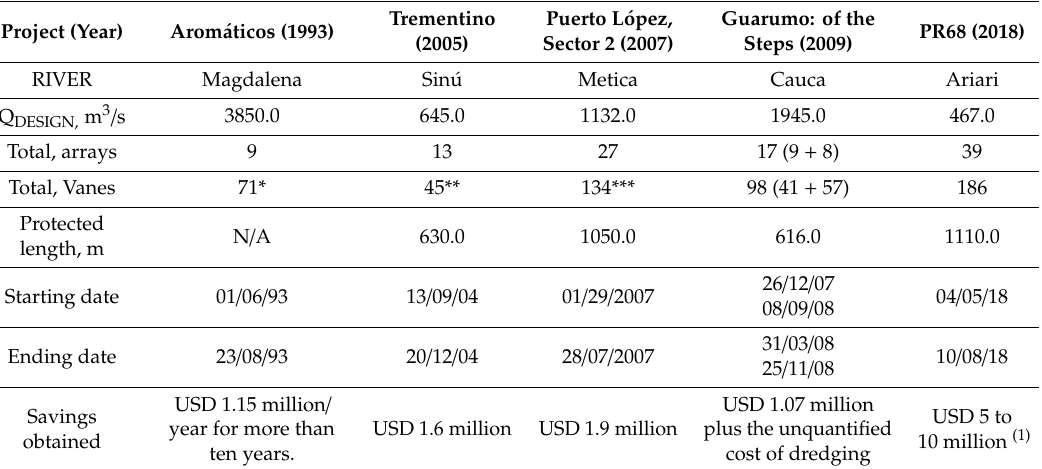
Table 4. Overview of the projects